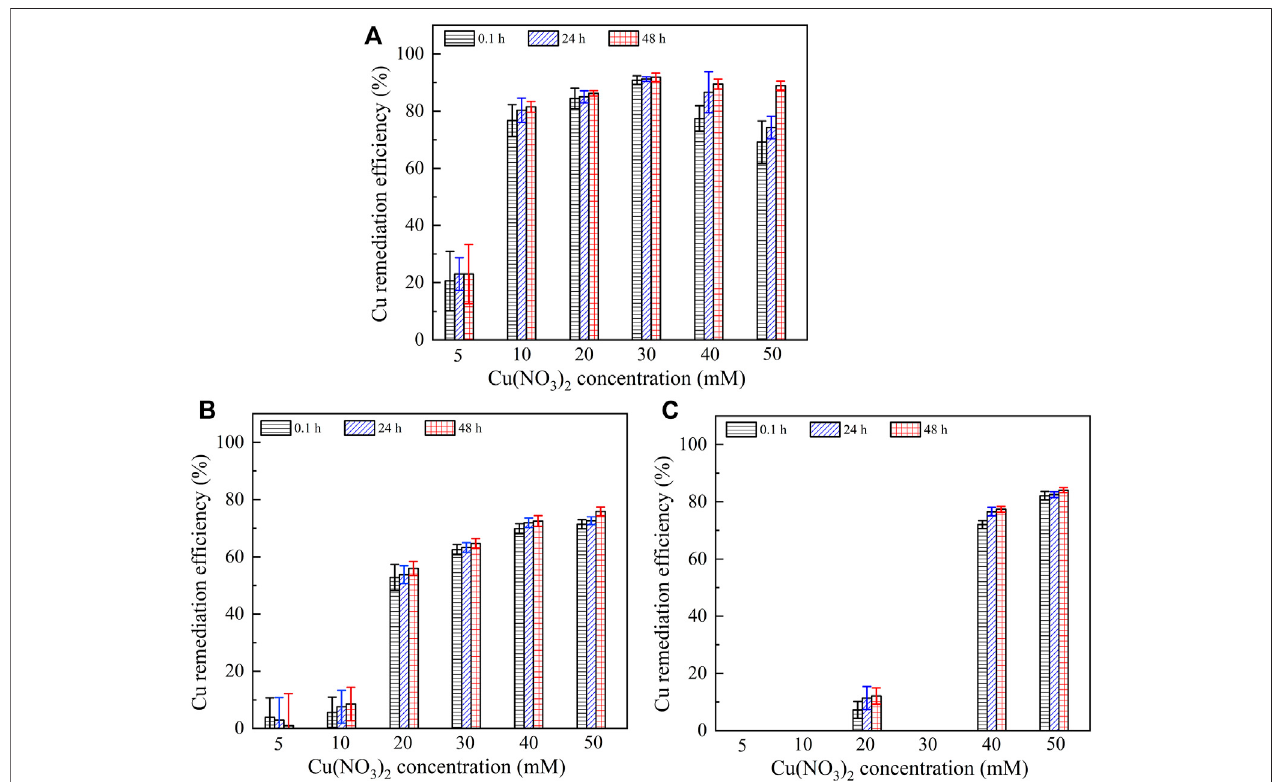
FIGURE 8 | Relationship of remaining Cu 2+ concentration and Cu remediation ef fi ciency versus Cu(NO 3 ) 2 concentration: (A) without yeast extract and CaCl 2 , (B) with yeast extract, and (C) with yeast extract and CaCl 2 .